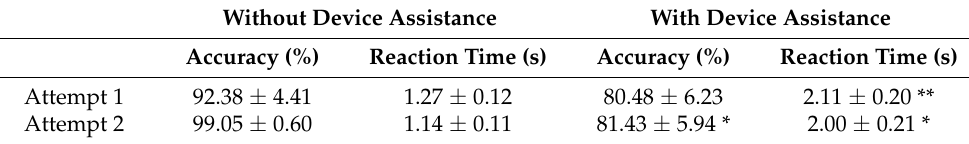
Table 1. Healthy subjects’ data for the acquaintance face recognition test ( n = 6). Without Device Assistance With Device Assistance Accuracy (%) Reaction Time (s) Accuracy (%) Reaction Time (s)